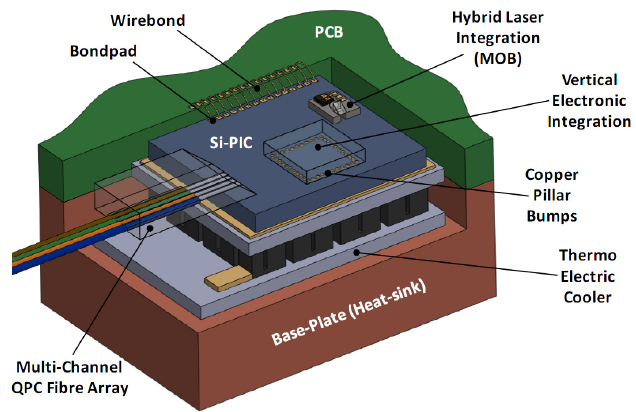
Figure 1. Schematic of a Si-PIC (photonic integrated circuit) packaged with a multi-channel quasi-planar coupled (QPC) fiber-array, a hybrid-integrated laser source based on a micro-optic bench (MOB), a vertically integrated electronic integrated circuit (EIC), and a thermo-electric cooler. Electrical connections between the PIC and PCB (printed circuit board) are made by wire-bonds, while the connections between the PIC and EIC are made using copper pillar bumps (CPBs).